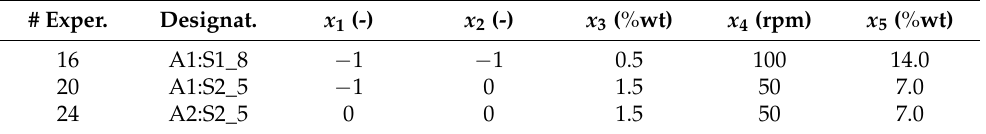
Table 7. Optimal formulations resulting from the optimization of secondary factors stage. #